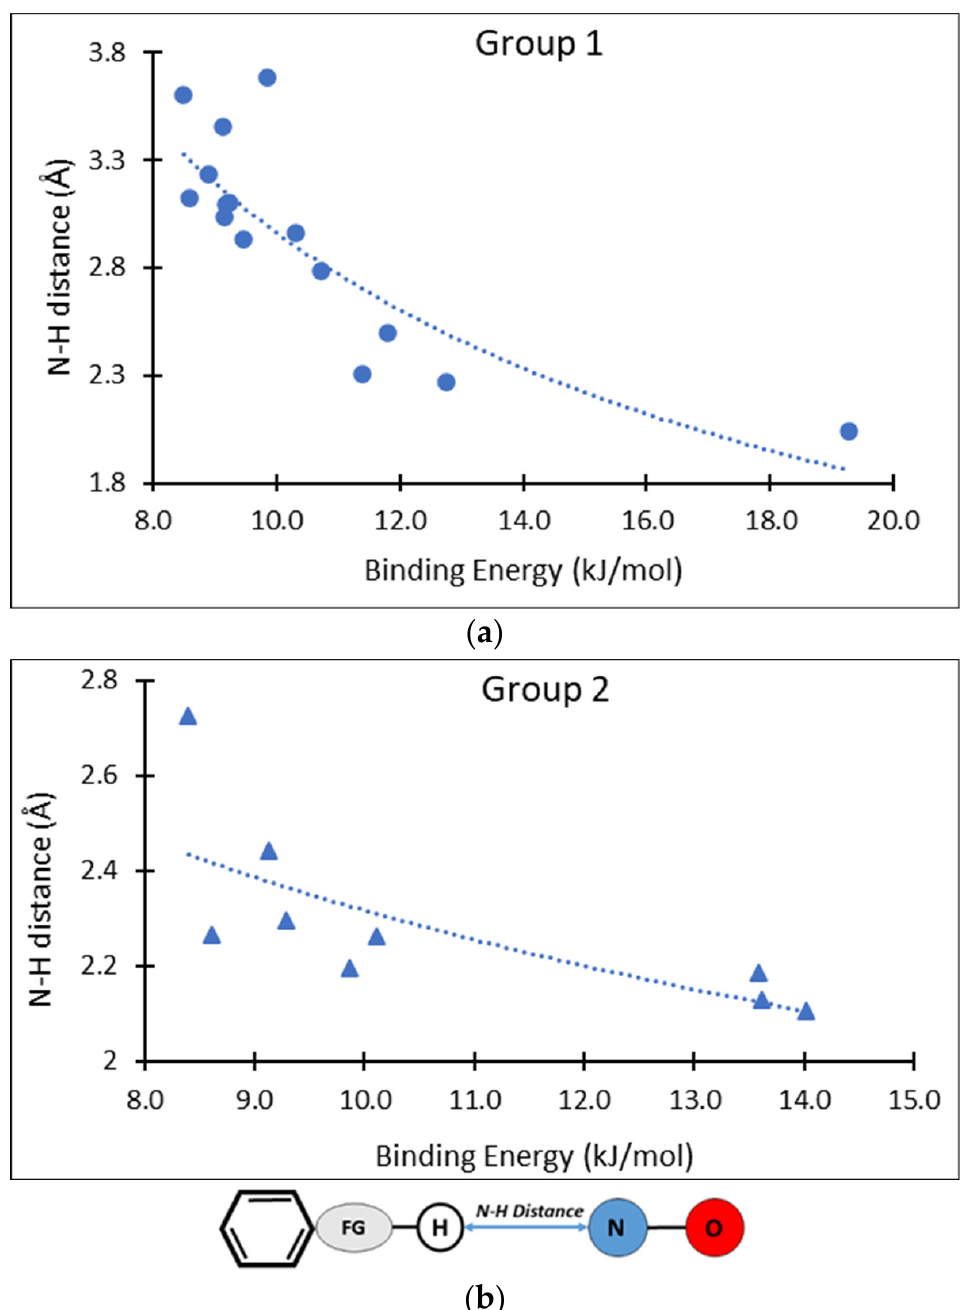
Figure 3. RI-DSD-BLYP/def2-TZVPP optimized geometries for the 10 most energetically favorable dimers.